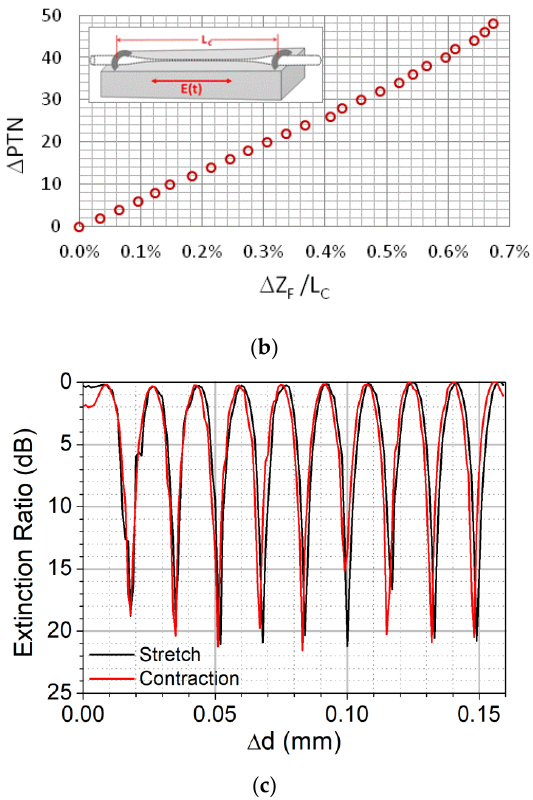
Figure 6. ( a ) Experimental optical transmission spectra of the tapered structure ( L = 84 mm, L c = 104 mm) showing FSR = 1.3 nm, insertion loss below 1 dB, and extinction ratio above 17 dB. ( b ) Linear strain sensing response: ∆ PTN versus strain ∆ Z F / L c at 1.55 µ m ranging from 0 to 0.7%. ( c ) Symmetric response of the sensor under stretch and contraction for length variation of ∆ d = 0.15